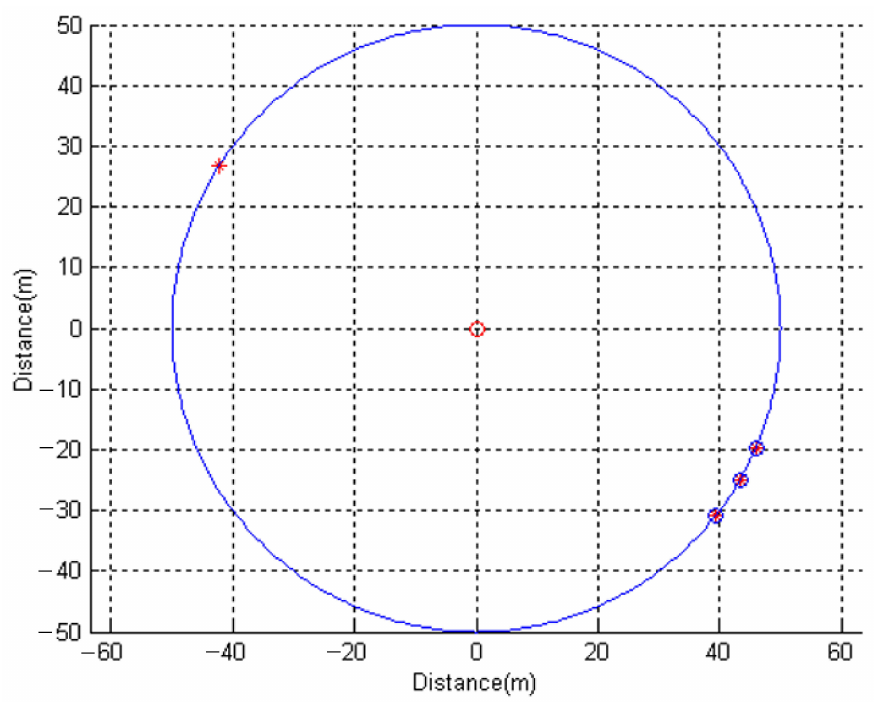
Figure 4. Deploy four reference nodes on the circle, and select three of them. * stands for that node is not selected.